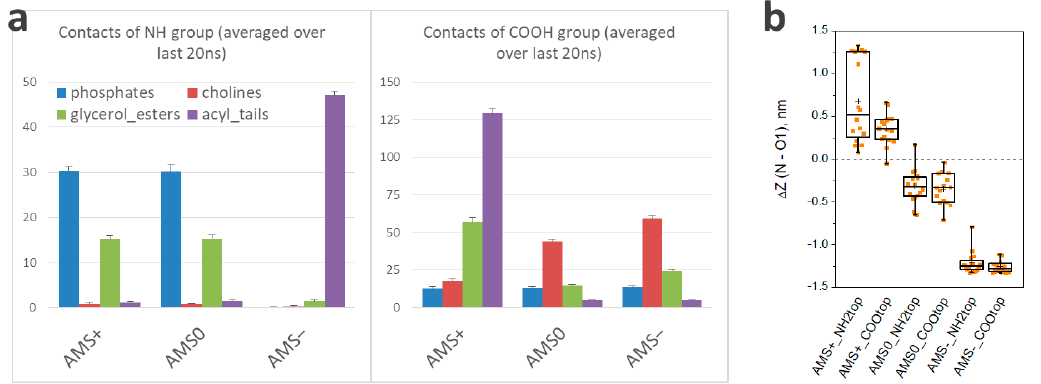
Figure 5. ( a ) Number of contacts between amino group or carboxylic group of AMS and different groups of lipids. Values are averaged for each form of AMS; standard error is shown; ( b ) vertical component of the distance between the amino group and carboxylic group; each point represents a single AMS molecule.